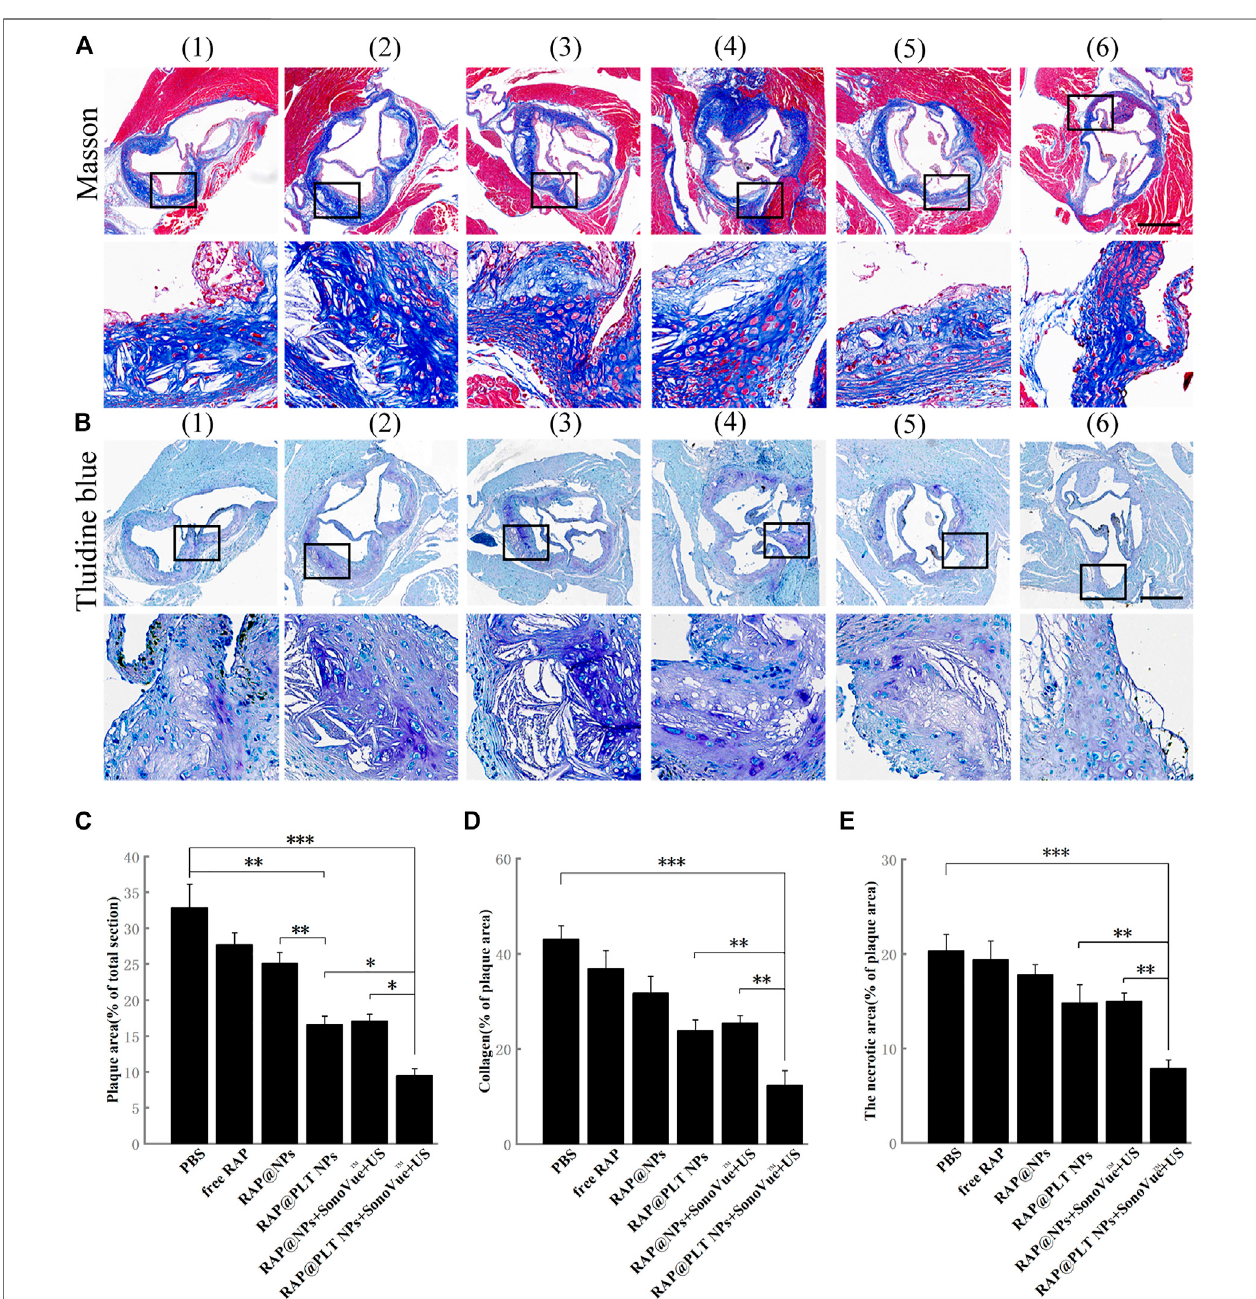
FIGURE 7 | Immunohistochemistry analyses of aortic root sections from ApoE − / − mice after different treatments. (A) The images of collagen in the plaque areas stainedbyMasson ’ strichrome(scalebar=500 µm). (B) TheimagesofthenecroticareasstainedbyToluidineblue(scalebar=500 µm)(Wangetal.,2021).-(Costagliola di Polidoro et al., 2021) referred to (Wang et al., 2021) PBS (Libby, 2012); free RAP (Shapiro and Fazio, 2016); RAP@NPs (Moriya, 2019); RAP@PLT NPs (Winkel et al., 2014); RAP@NPs + SonoVue ™ + US (Costagliola di Polidoro et al., 2021); RAP@PLT NPs + SonoVue ™ + US. (C) Quantitative data of the atherosclerotic plaque areaintheaorticrootsections. (D) Quantitativedataofthecontentofcollageninaorticrootsections. (E) Quantitativedataofthenecroticareasintheaorticrootsections. n = 5, mean ± SD, * p < 0.05, ** p < 0.01, and *** p < 0.001.